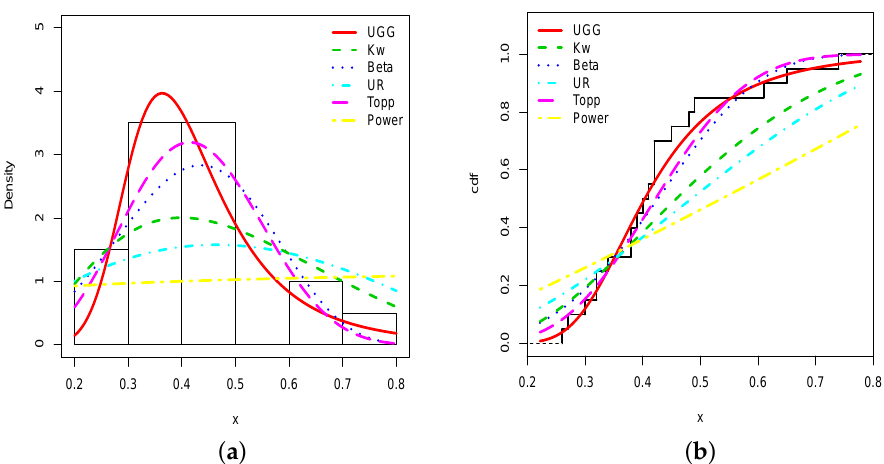
Figure 8. Plots of the ( a ) estimated pdfs and ( b ) estimated cdfs of the considered models and the flood level data set.